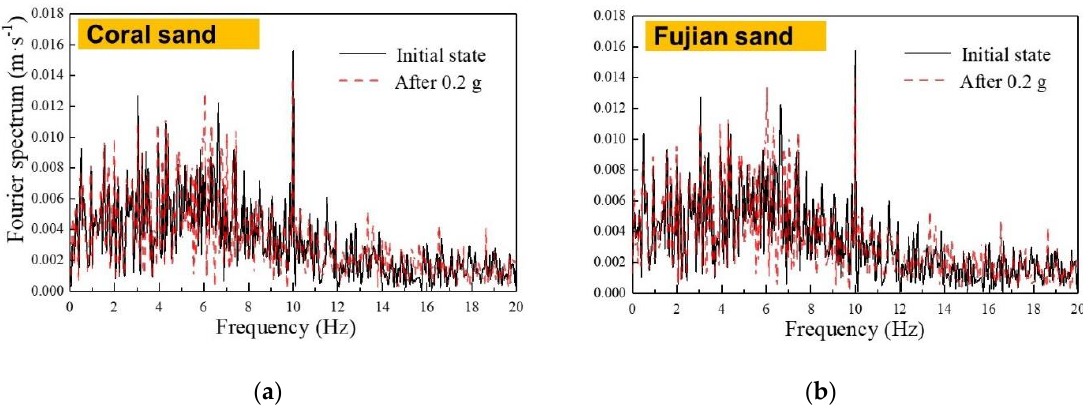
Figure 11. Fourier analysis of white noise: ( a ) coral sand; and, ( b ) Fujian sand.